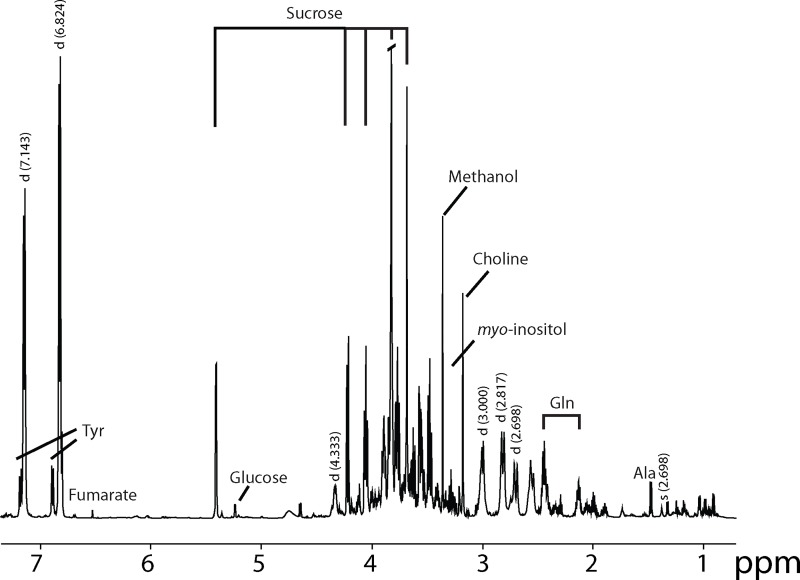
1H-NMR spectrum of nopal extract.